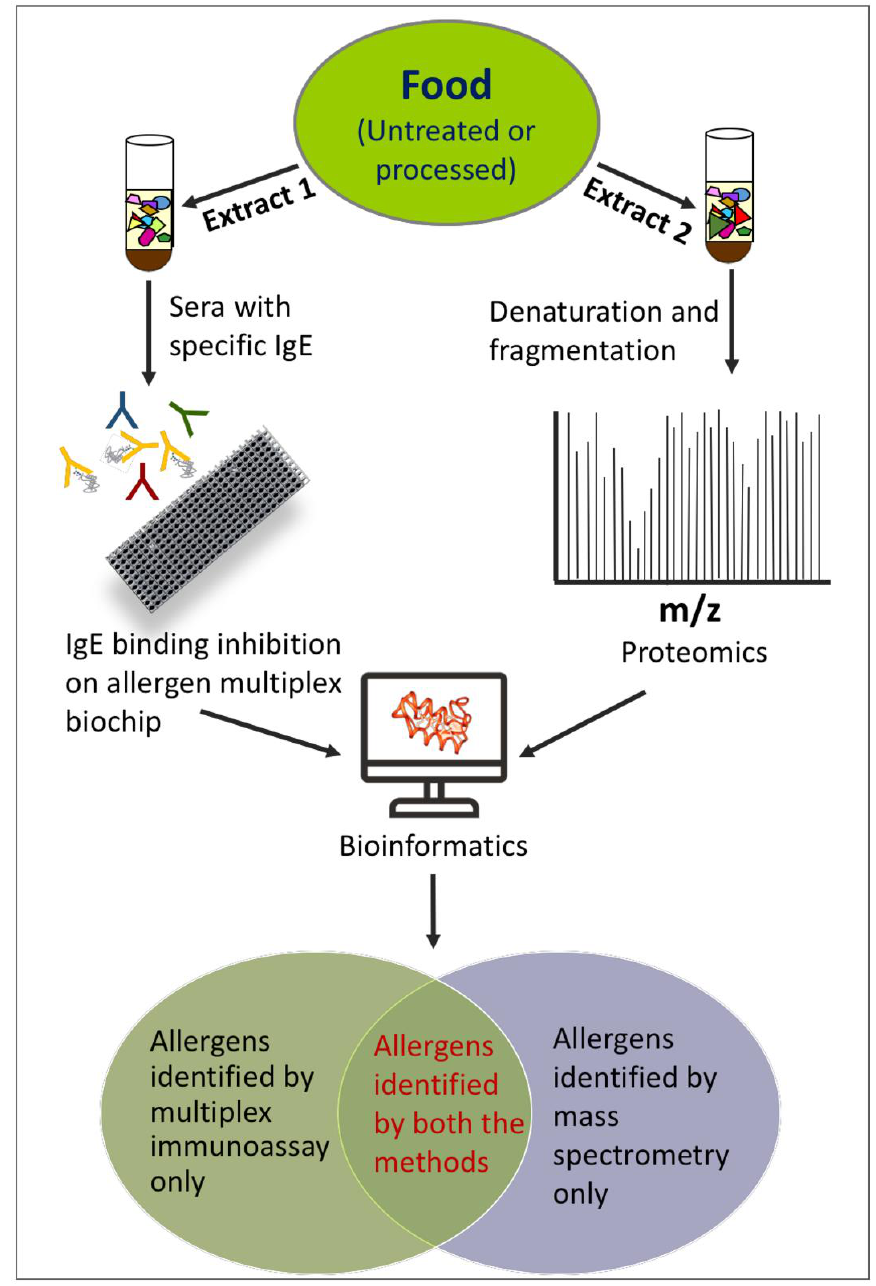
Figure 2. Schematic representation of two procedures used to obtain the allergen profile in a food: inhibition test on a multiplex allergen biochip (on the left) and mass-spectrometry-based procedure (on the right).